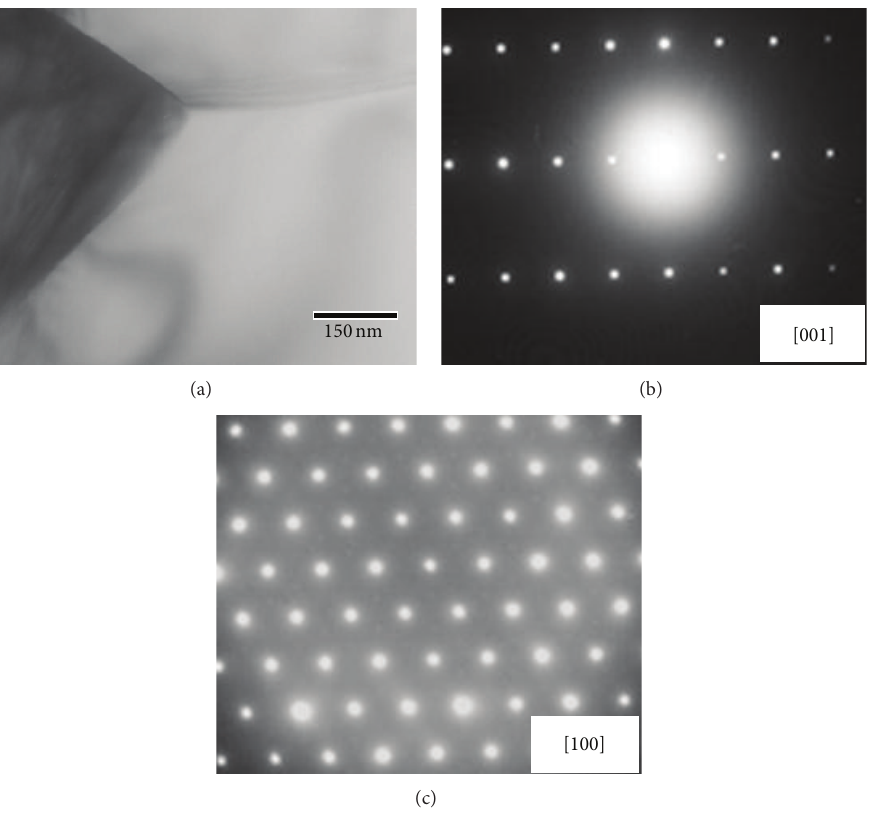
Figure 6: Typical TEM bright-field image (a) and selected area diffraction patterns ((b) and (c)) of the EDC Ti 5 Si 3 compact at 7.0 kJ of input energy [13].